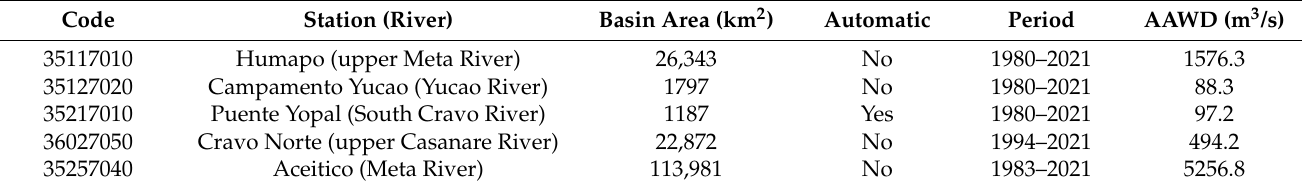
Table 3. The gauging stations used in the study (AAWD–annual average water